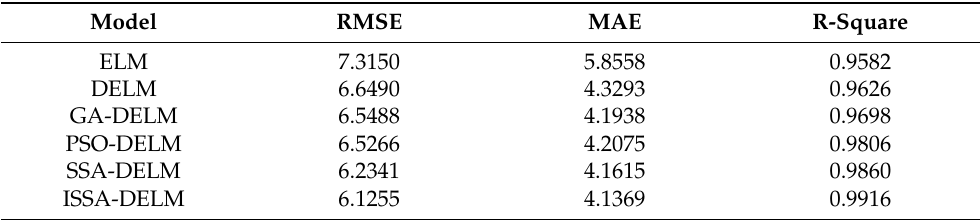
Table 3. Comparisons between the ELM, DELM, PSO-DELM, GA-DELM, SSA-DELM, and ISSA- DELM models for DTS estimation in Well N.